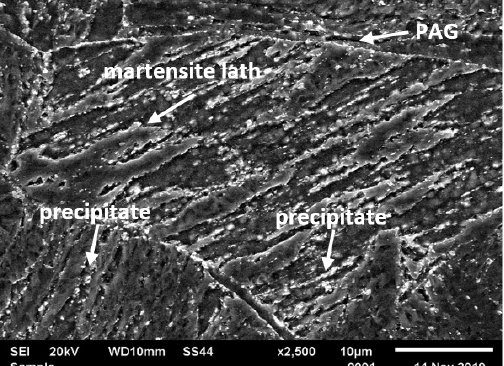
Figure 5. Macroscopic image of test joints: ( a ) joint No. 1; ( b ) joint No. 2; where: WM-weld; HAZ—heat affected zone; BM—basic material.